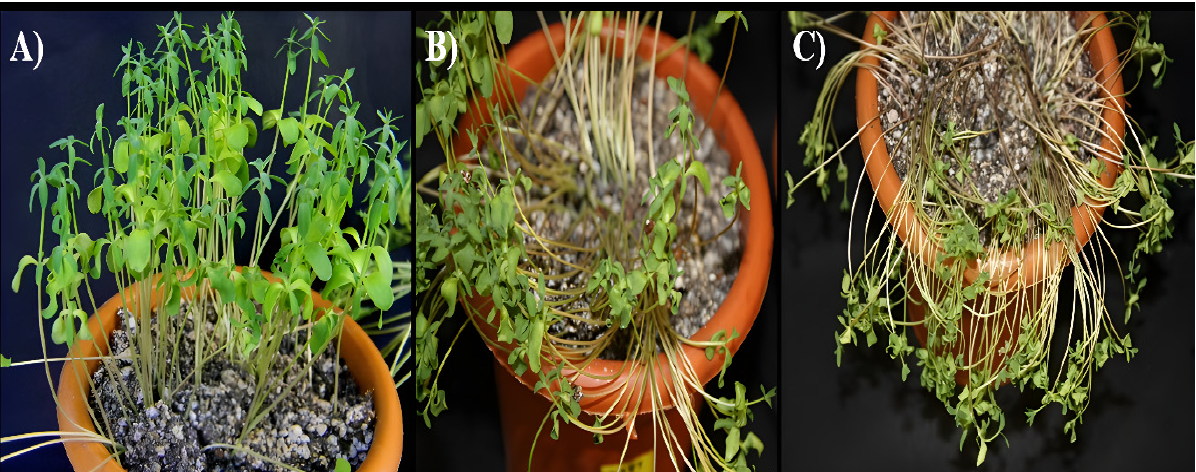
Figure 1. Drought stress induction and appearance of drought and oxidative stress symptoms in flax. ( A ) Unstressed control plants, ( B ) four-day stressed plants, and ( C ) five-day stressed plants showing visible symptoms of drought. The plants were grown at 16 h/20 °C (day) and 8 h/18 °C (night) for 21 days before induction of stress.